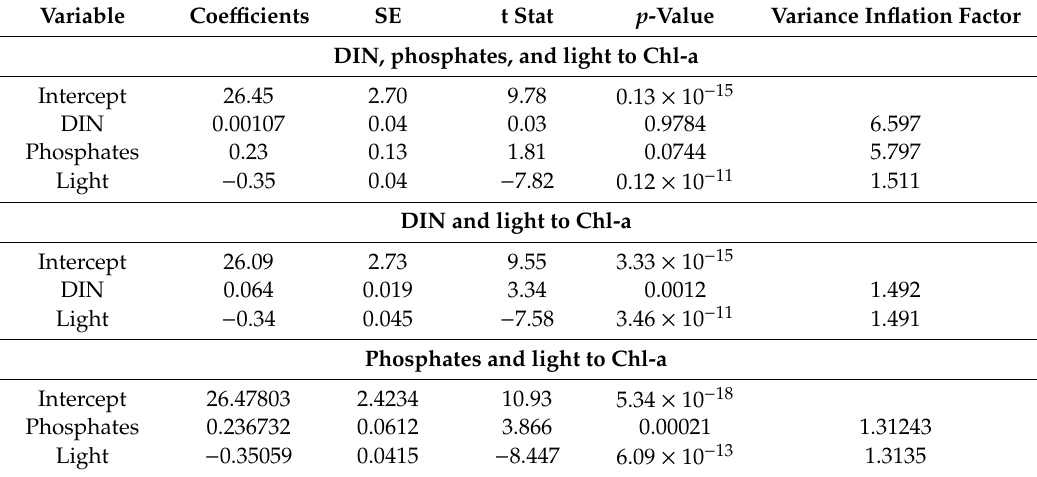
Figure 7. Spatial distribution of mean phytoplankton biomass (µg L −1 ) in Jakarta Bay. Table 2. Multiple regression properties between dissolved inorganic nitrogen (DIN), phosphates, and light to chlorophyll-a